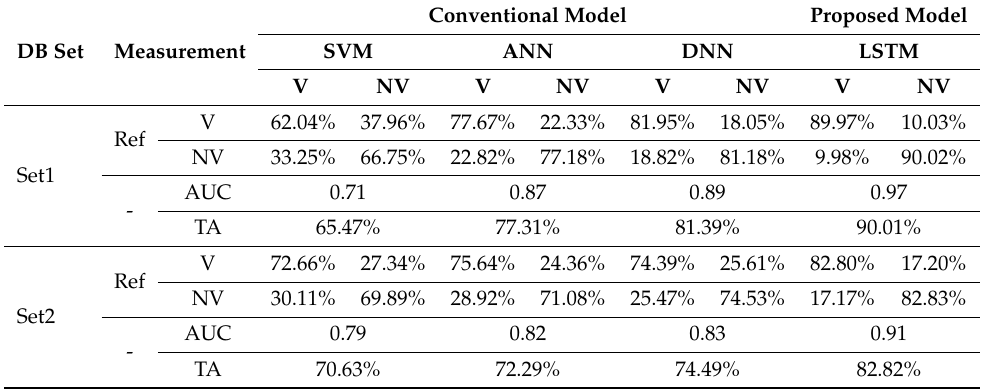
Table 1. Experimental results of the proposed model and conventional model for all frequencies of the ES. Abbreviations; voluntary (V), non-voluntary (NV), reference (Ref), total accuracy (TA).